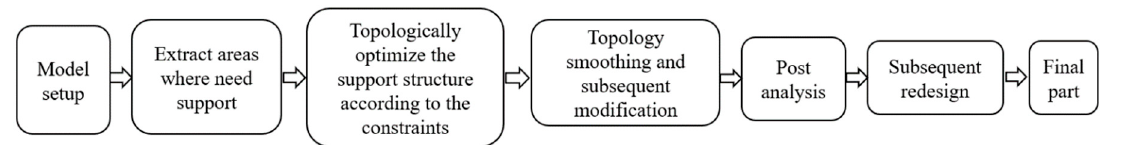
Figure 8. Workflow of topology optimization for support structures.